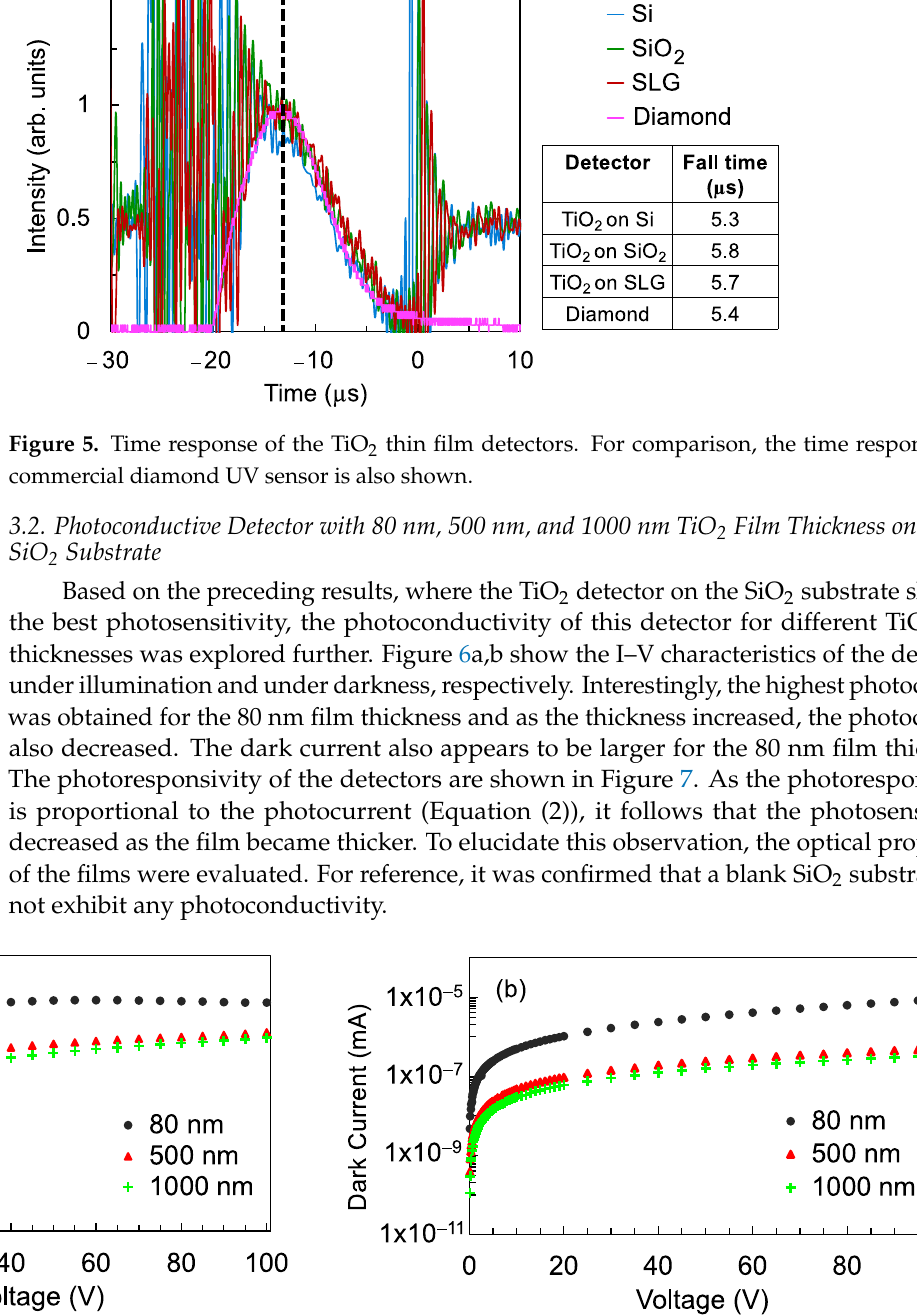
Figure 7. Photoresponsivity of the detectors with 80 nm, 500 nm, and 1000 nm thick TiO 2 film on SiO 2 substrate. Figure 8a shows the transmission spectra of the TiO 2 thin films with thicknesses of 80 nm, 500 nm, and 1000 nm. The transparency of the film around the short wavelength end of the spectrum from about 350 nm to 500 nm is observed to decrease as the thickness increased. The transmission edge also shifted to a longer wavelength and correspond- ingly, the optical band gap decreased, as shown in the Tauc plots in Figure 8b. The de- crease in transparency and optical band gap indicates that the number of defects in the film increased as the film became thicker. Oxygen vacancies and trivalent titanium ions are the most common defects formed in TiO 2 and these defects create deep electron traps, which manifest as localized states that are 0.75–1.00 eV below the conduction band mini- mum [31,32]. The presence of these localized states effectively decreased the optical band gap as well as the transmittance around the 350 nm to 500 nm wavelength range of the thicker films. 0.000 0.001 0.010